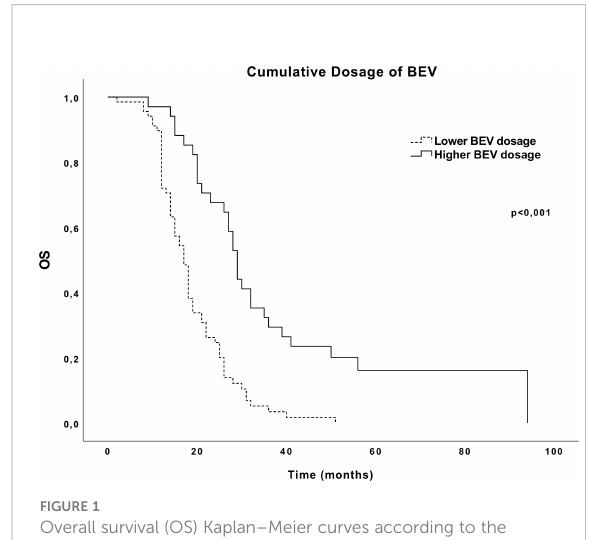
FIGURE 1 Overall survival (OS) Kaplan – Meier curves according to the cumulative dosage of